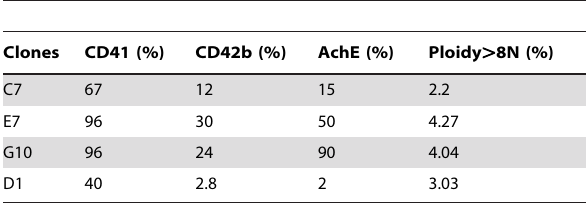
Table 1. Generation of MK clones showing different degrees of differentiation.